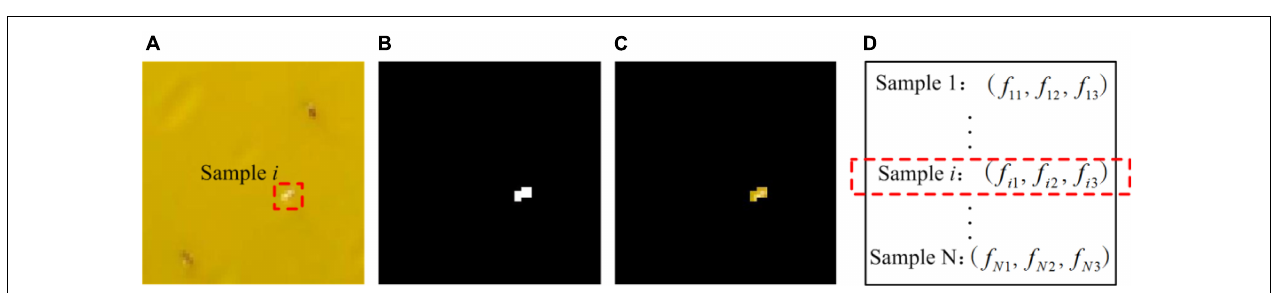
FIGURE 6 | Determination of the threshold value for each saliency map.